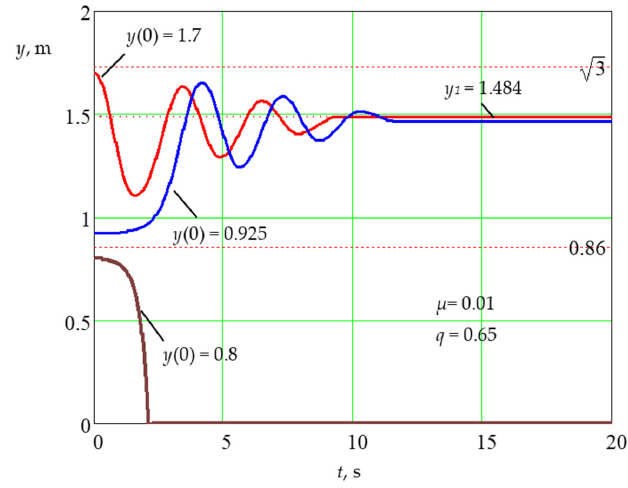
Figure 12. Motion of a system with friction from different starting points with a rigidity of the thread sufficient for the occurrence of free vibrations.